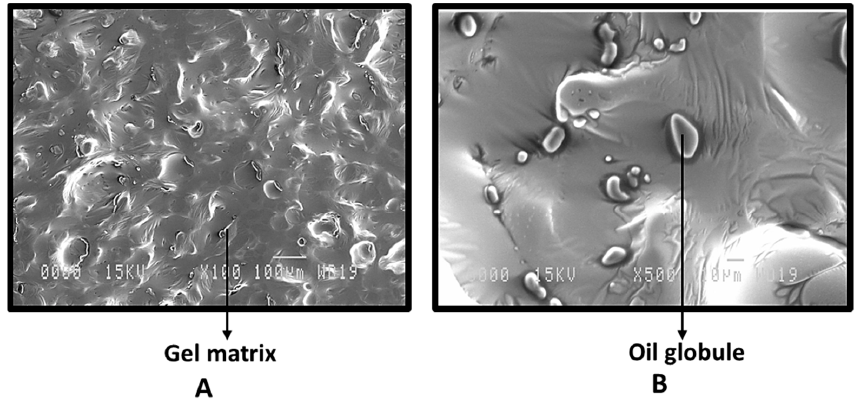
Figure 6. Scanning electron microscopy of Bacillus coagulans -loaded suppository ( A ) 100 × ( B ) 500 × magnification.